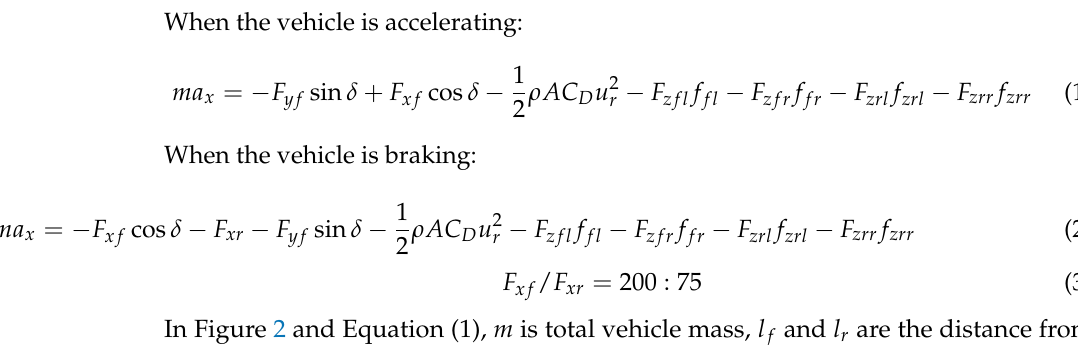
Figure 2. Schematic diagram of the seven-degree-of-freedom dynamic model of a vehicle. According to Newton’s second law, the longitudinal kinematics equation can be obtained at the center mass of the vehicle.